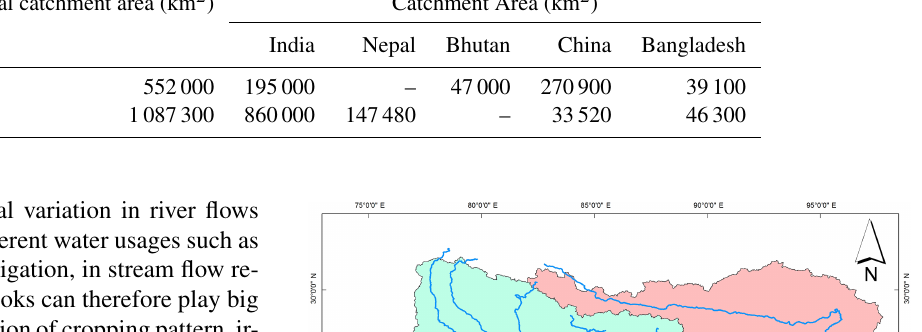
Table 1. Catchment Area of Brahmaputra and Ganges River. River Basin